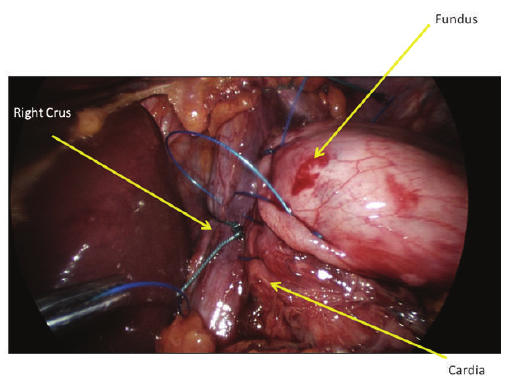
Figure 2: Right sided fixation suture involving running bites along entire length of